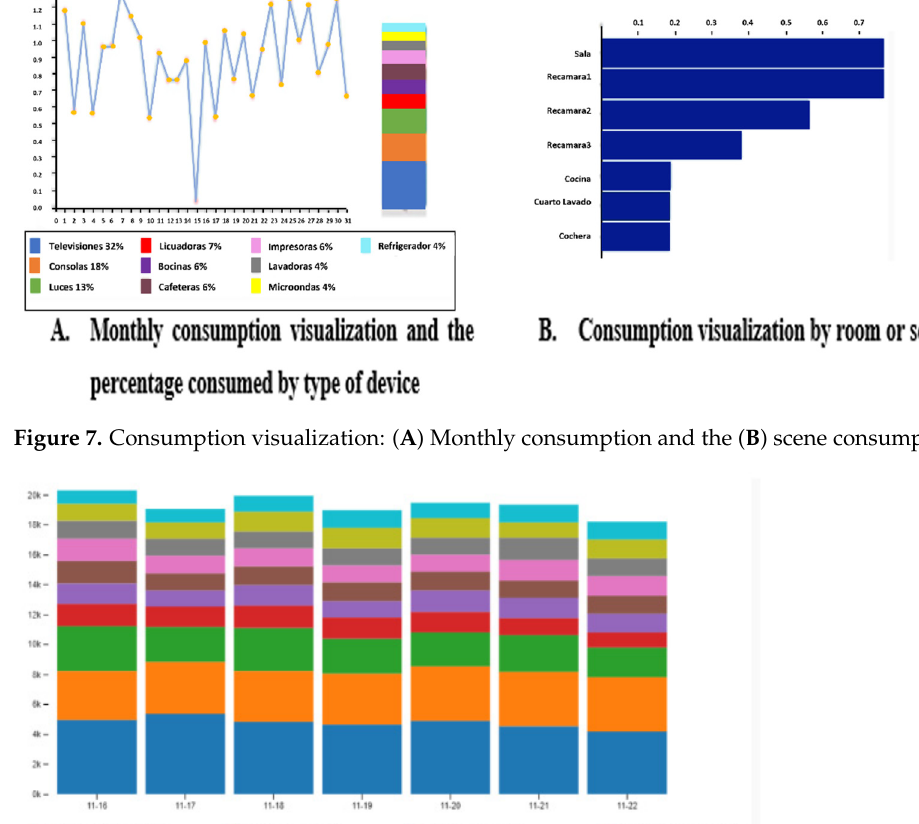
Figure 7. Consumption visualization: ( A ) Monthly consumption and the ( B ) scene consumption.